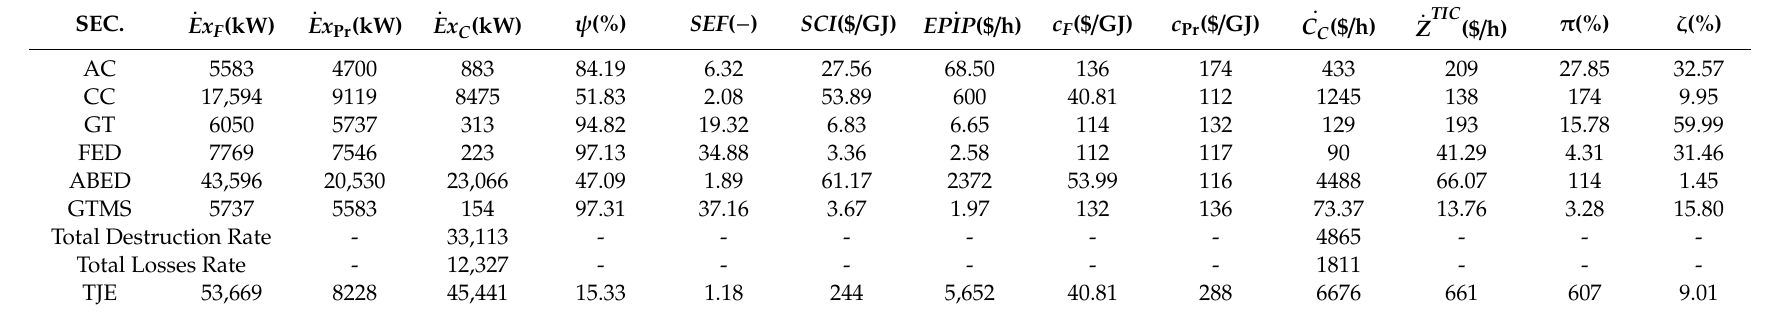
Table 13. Results for exergy, exergoeconomic and sustainability performance indicators for AB PM with hydrogen fuel